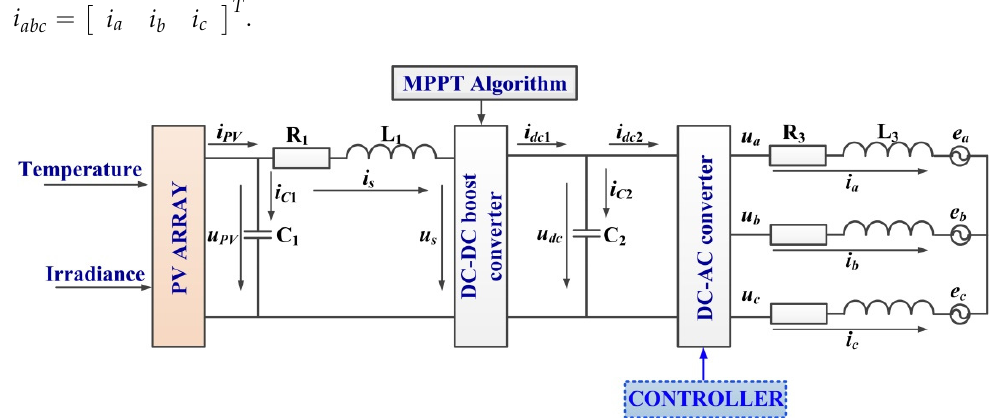
Figure 1. The schematic block of the main circuit for the GC-PV system.